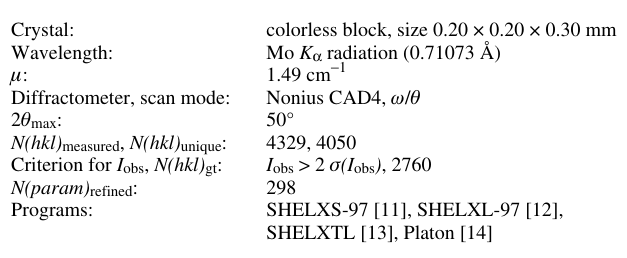
Table 1. Data collection and handling.